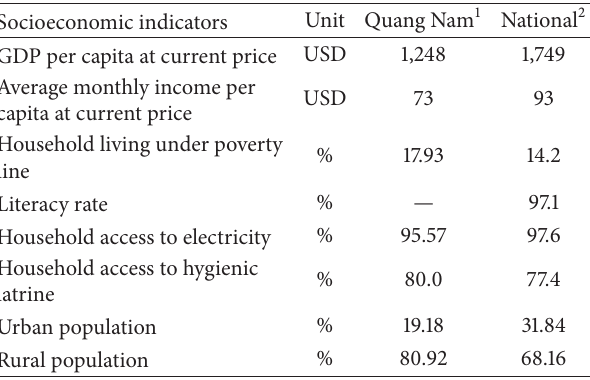
Table 1: Socioeconomic indicator of Quang Nam province,